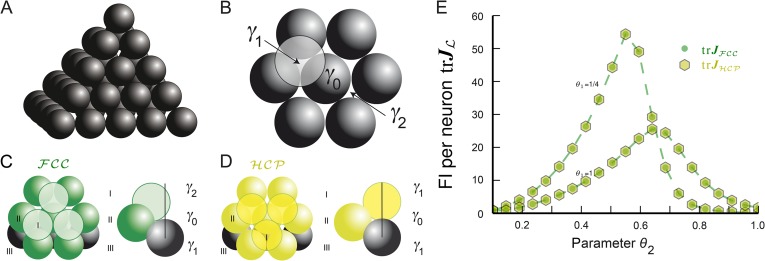
Lattice and non-lattice solutions in 3D.(A) Stacking of spheres as in an FCC lattice. In this densest lattice in 3D, each sphere touches 12 other spheres and there are four different planar hexagonal lattices through each node. (B) Over a layer of hexagonally arranged spheres centered at γ0 (in black) one can put another hexagonal layer by starting from one of six locations, two of which are highlighted, γ1 and γ2. (C) If one arranges the hexagonal layers according to the sequence (…,γ1, γ0, γ2,…) one obtains the FCC. Note that spheres in layer I are not aligned with those in layer III. (D) Arranging the hexagonal layers following the sequence (…,γ0, γ1, γ0,…) leads to the hexagonal close packing HCP. Again, each sphere touches 12 other spheres. However, there is only one plane through each node for which the arrangement of the centers of the spheres is a regular hexagonal lattice. This packing has the same packing ratio as the FCC, but is not a lattice. (E) trJL for bump-function Ω with L=FCC and HCP for various parameter combinations θ1 and θ2; θ1 modulates the decay and θ2 the support. The two packings have the same packing ratio and for this tuning curve also provide identical spatial resolution. FI: Fisher information.